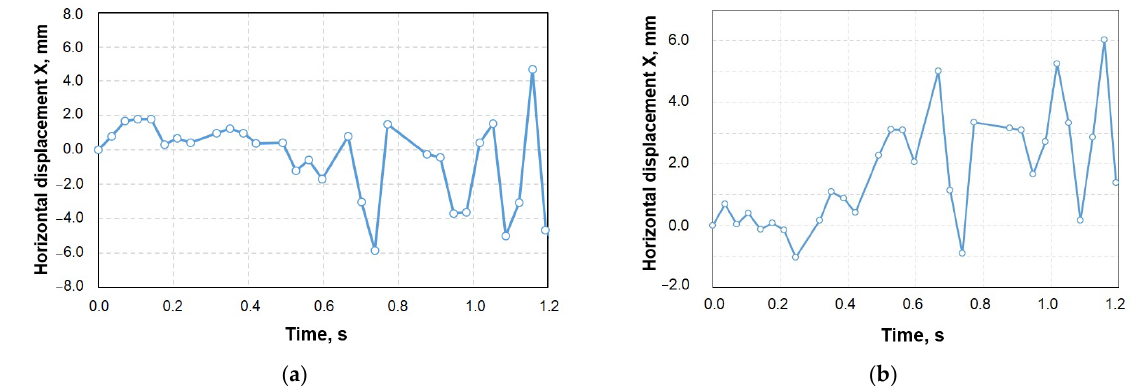
Figure 10. Displacement history of joint C for the X direction ( a ) and displacement history of the middle part of column 2 for the X direction ( b ).